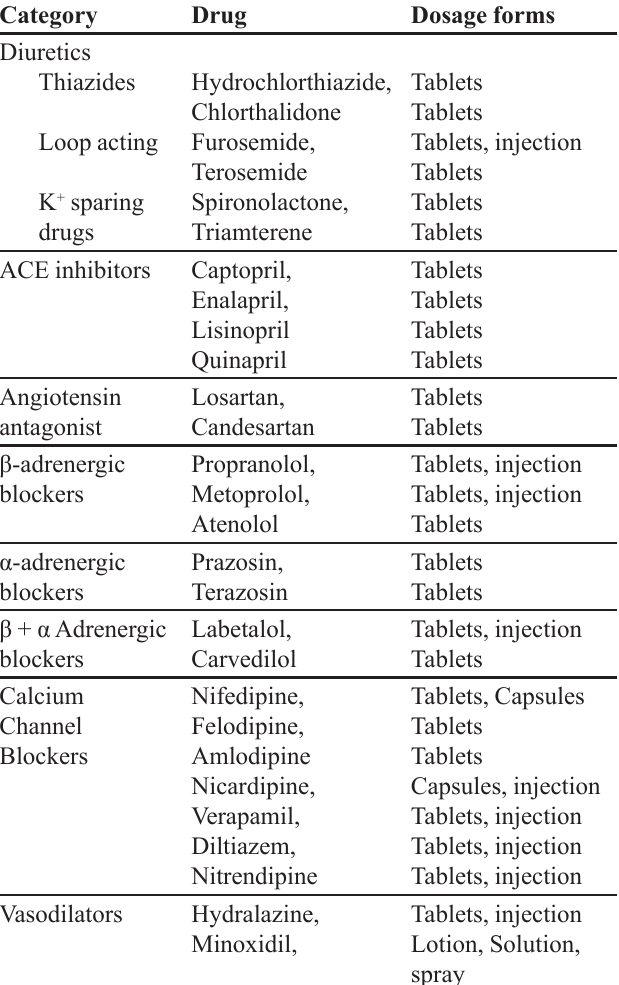
TABLE I - The commercial dosage forms of antihypertensive drugs